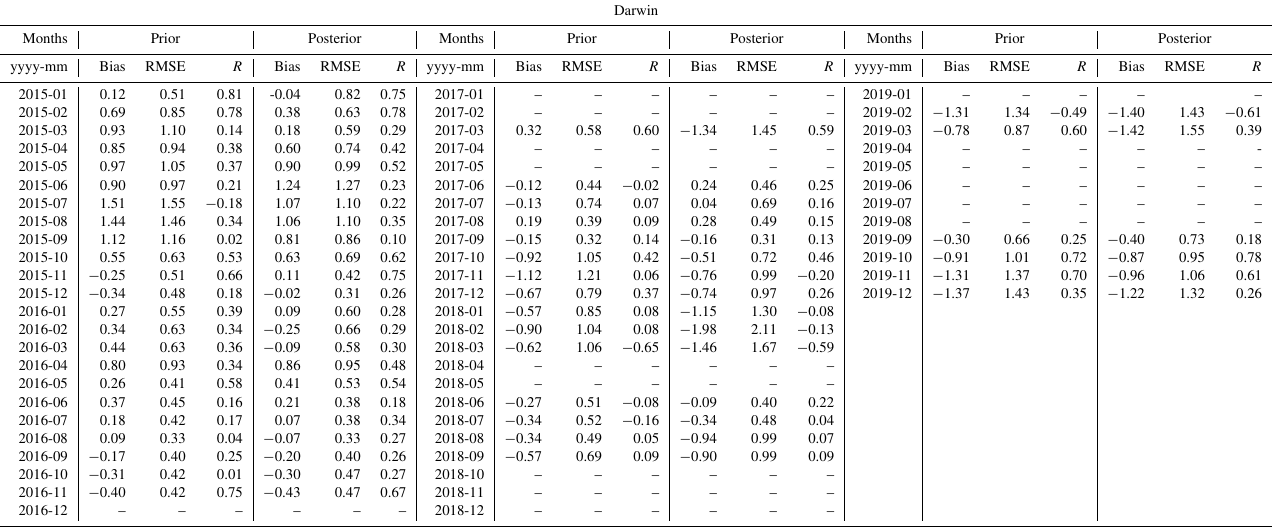
Table F1. Analysis of the residual between CMAQ prior and posterior simulation values and the TCCON Darwin site for the 2015–2019 period, showing the averaged bias (Bias), root-mean-square error (RMSE), and Pearson coefficient ( R ).